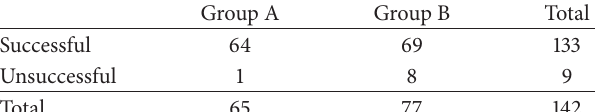
Table 1: Graft uptake rates of patients in both groups.